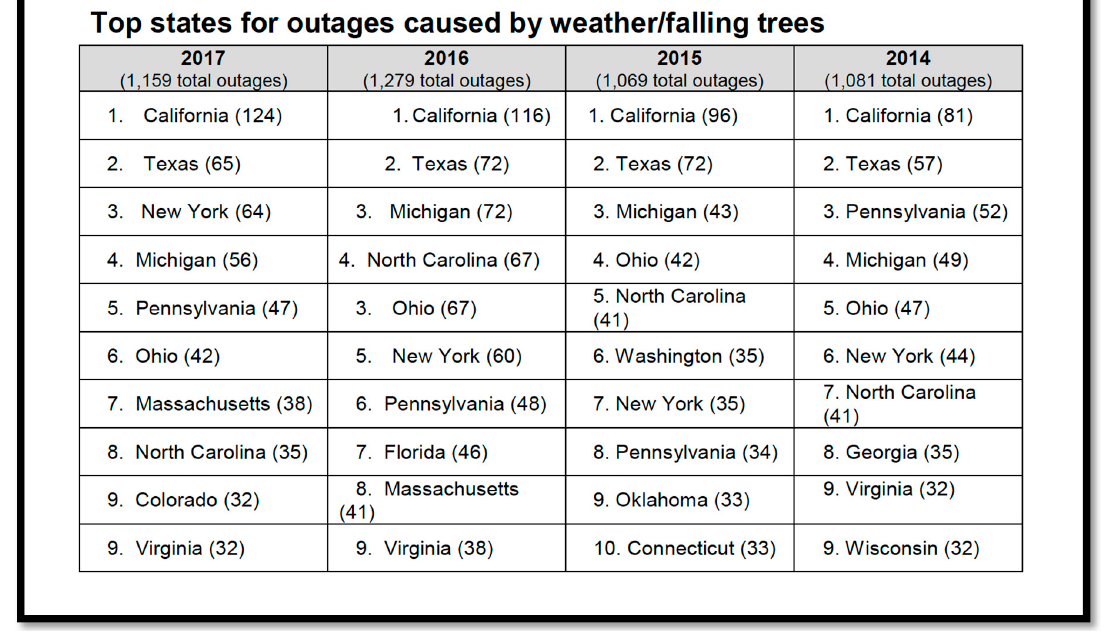
Figure 2. Eaton’s Blackout Tracker [40].